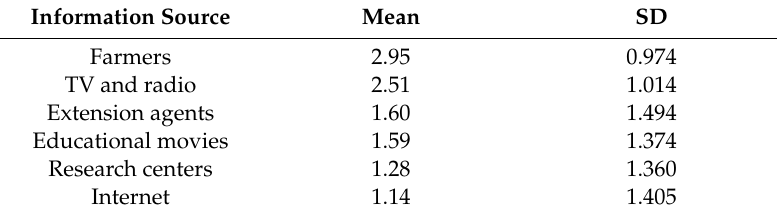
Table 6. Usefulness of information sources among rice growers of Rudsar County ( n =